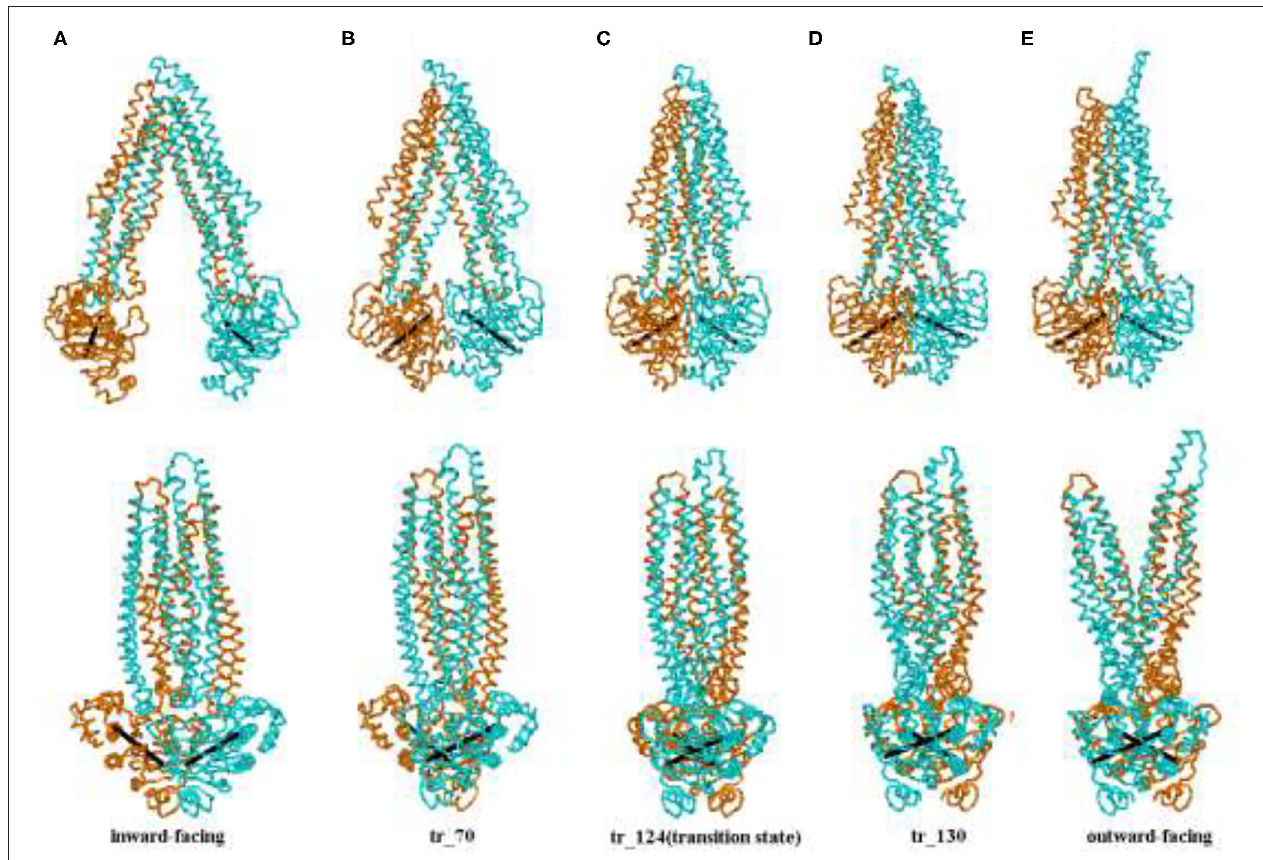
FIGURE 3 | (A–E) Representative conformation sampling along the allosteric pathway. The lower snapshots are obtained by rotating the corresponding upper ones to 90 ◦ counterclockwise. The two lines, respectively, connect C α atoms of the residues L413 and K536, E1059, and K1181 in two-nucleotide binding domain (NBD).